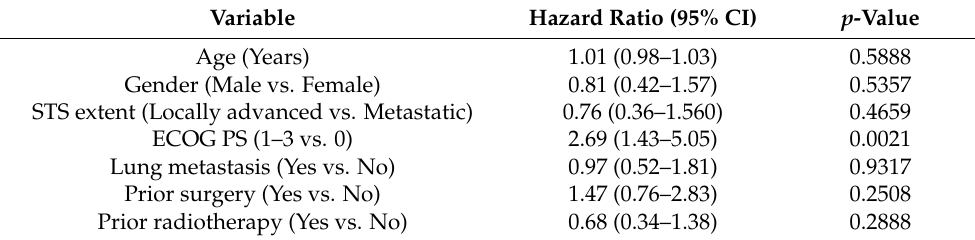
Table 3. Univariable Cox regression analysis of PFS.